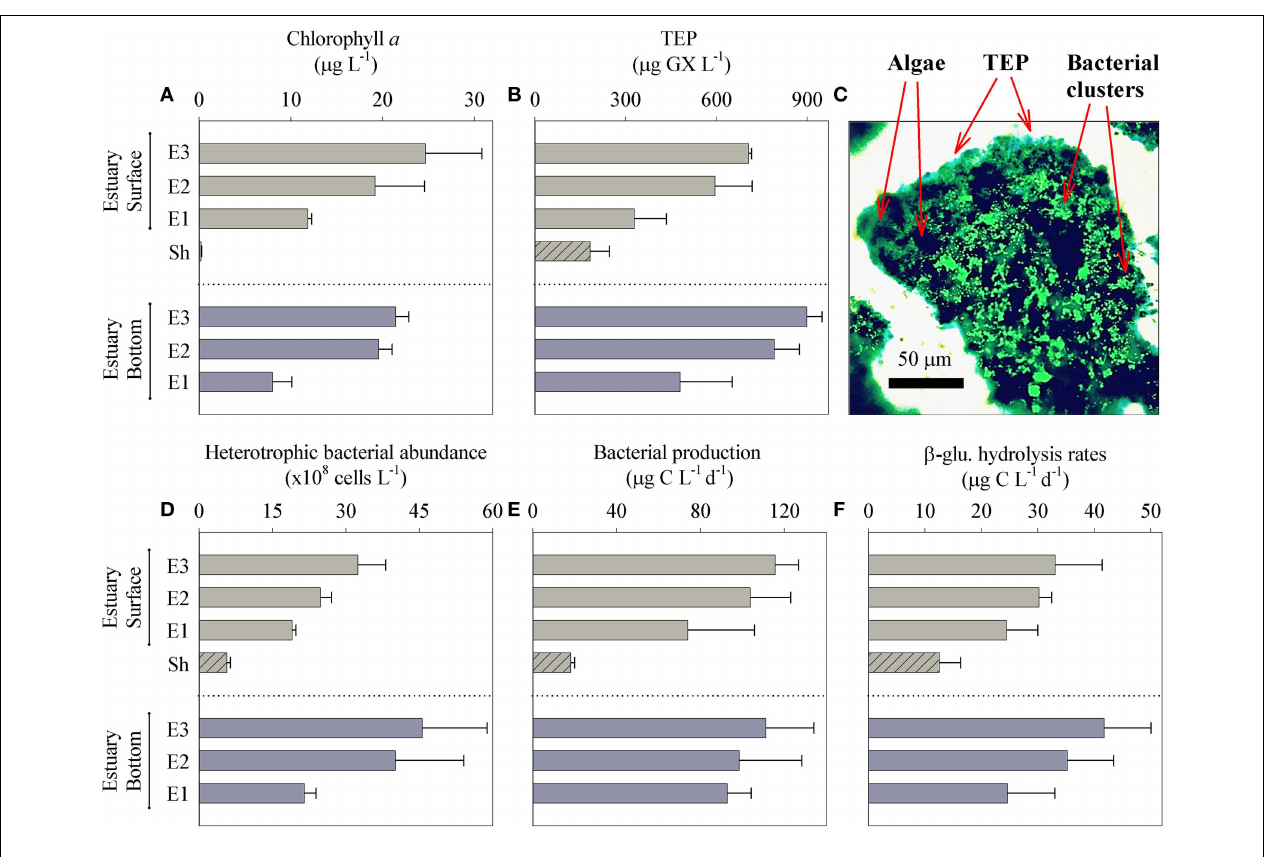
standard deviation. To visualize bio-aggregates water were sampled from a representative station (E1). Bacterial clusters were stained with SYTO 9 (bright green) and captured with epifluorescent microscopy. Bright field microscopy was used to visualize transparent exopolymers particles (TEP) stained with alcian blue (as light blue), and algal cells (as dark green). Images were superimposed using Image J software ( http:// rsbweb.nih.gov ). Chlorophyll a pigment was not detected by autoflorescence within the bacterial